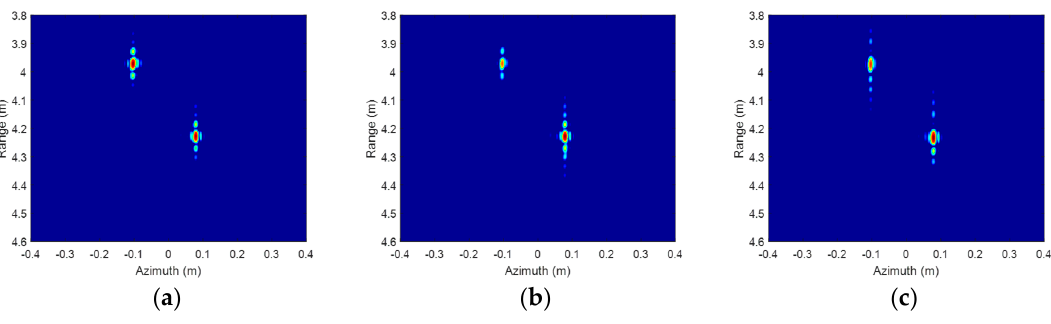
Figure 5. ISAR imaging results of two corner reflectors before signal calibration. ( a ) Antenna A; ( b ) Antenna B; ( c ) Antenna C.